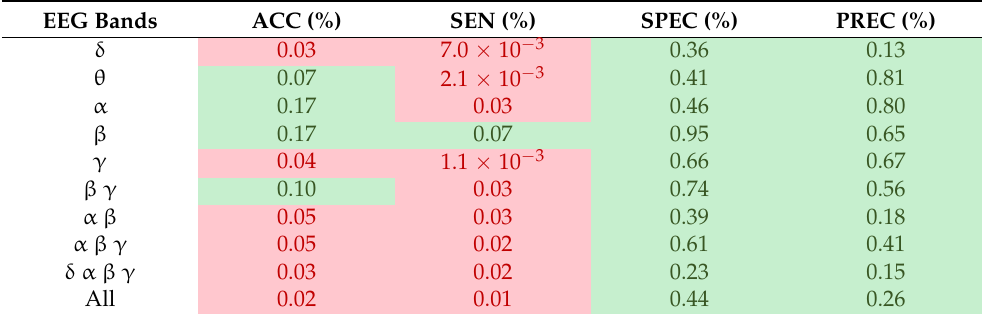
Table 3. p -values F (1, 56) obtained using series of ANOVA between two scenarios. Results marked in green mean that there is not enough evidence for differences between scenarios, in red, there is. The results for the one hidden neuron.